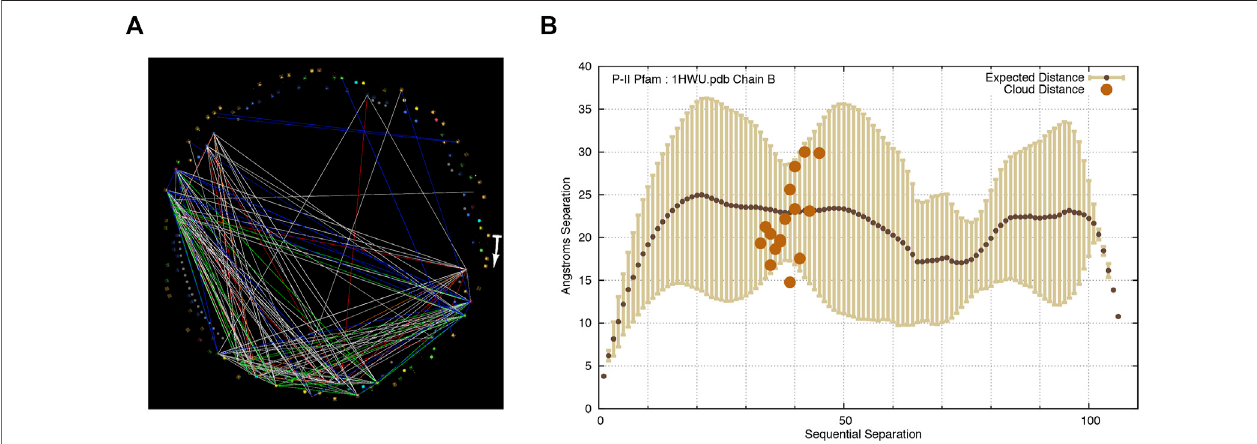
FIGURE 3 | In P-II, an unmistakable cluster of co-evolving residues appears at similar T r and P thresholds, but the distances between the implicated residues are scatteredboth aboveand belowtheexpected distanceforresidues ofsimilar sequential separation. Thestartofthearrow insub fi gure (A) indicatestheN-terminal ofthe